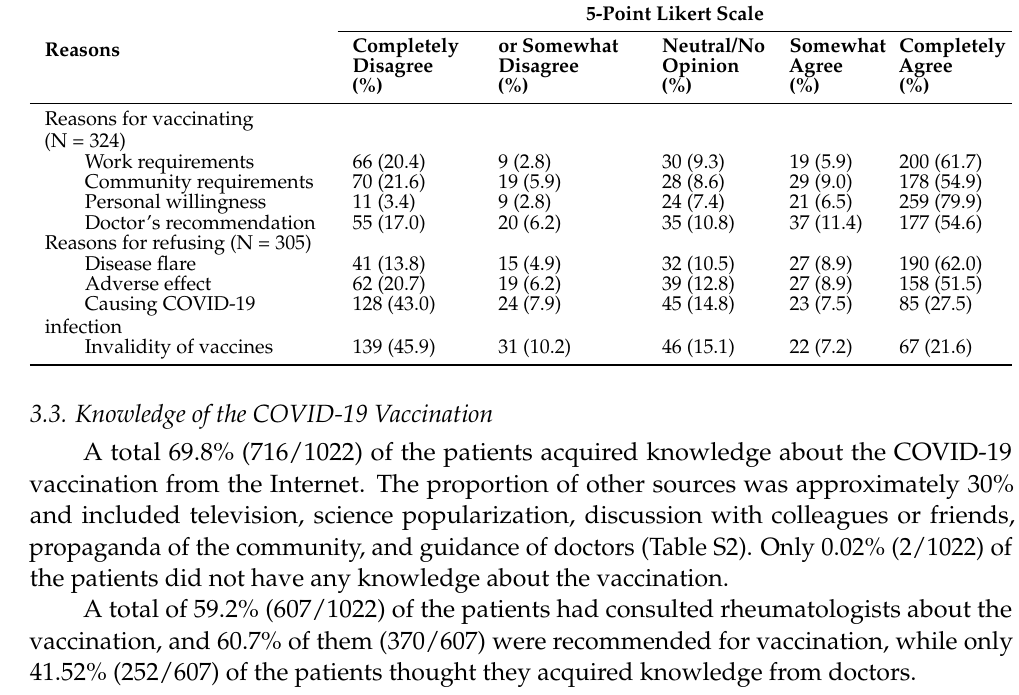
Table 3. The reasons for vaccinating or refusing vaccination. 5=, 4=, 3=, 2= and